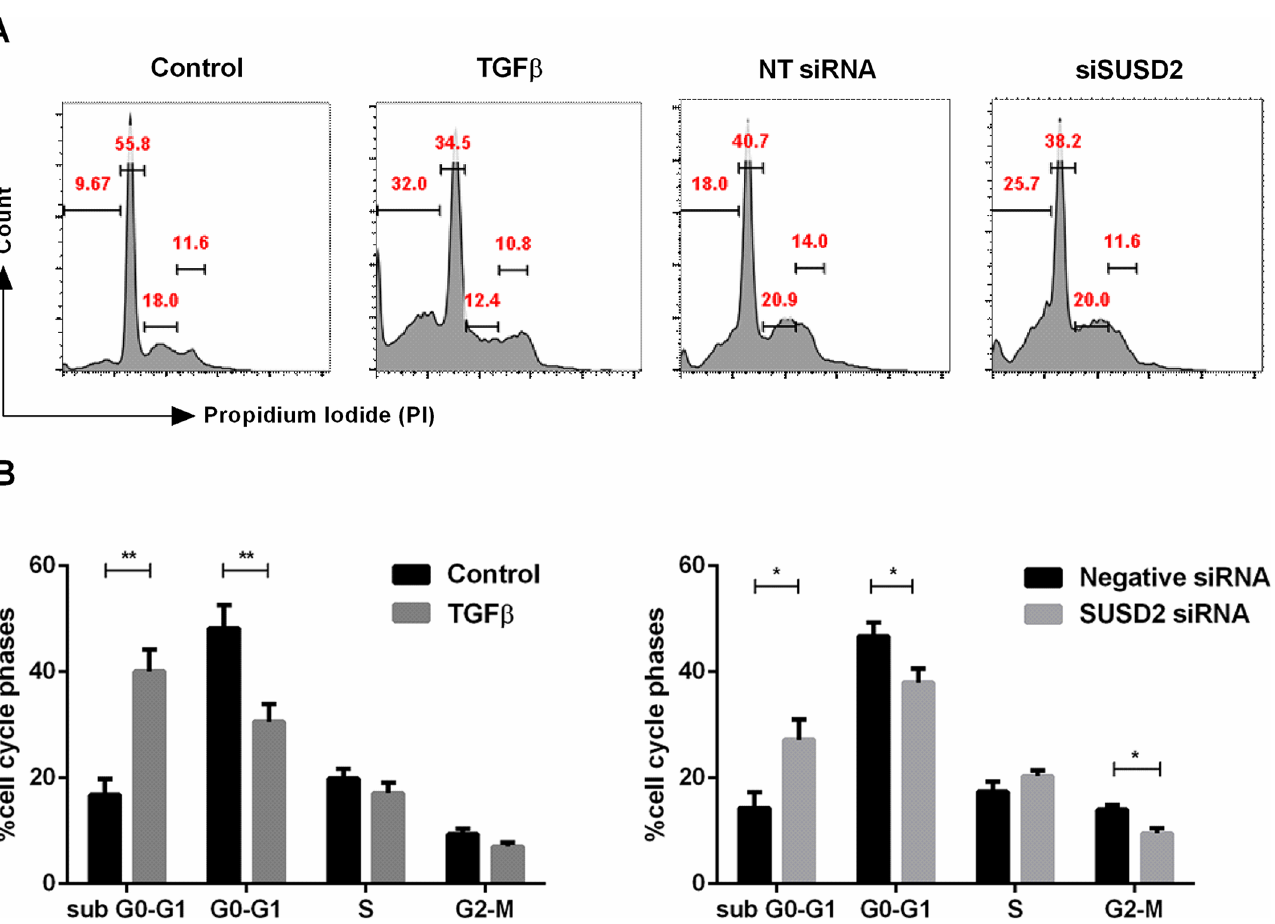
Fig 4. Effect of SUSD2 on cell death. (A) Representative FACS plots showingcell cycle progression of Ishikawa cells characterized by Propidium Iodide (PI) staining after 72h TGF β (10 ng/ml) or Non-targeting (NT) or with SUSD2 siRNA treatment as indicated. Sub G0/G1 represents the apoptotic fraction. (B) Arithmetic means ± SEM (n = 5–6) of percentagecells in different cell cycle phases. * P < 0.05, ** P < 0.01 indicatesstatistically significant difference from control cells using Student’st-test.